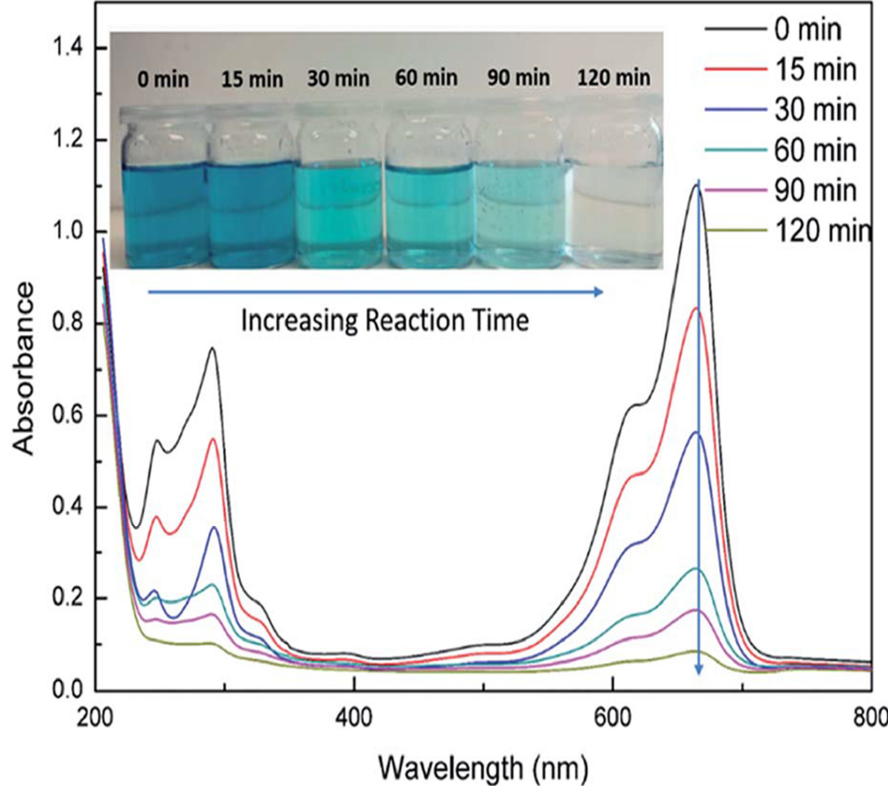
Figure 8. UV-Vis analysis of the photocatalytic degradation of MB by cellulose/GO/TiO 2 hydrogel with the reaction time [205]. Adapted with permission from Royal Society of Chemistry (license ID 1079849-2).